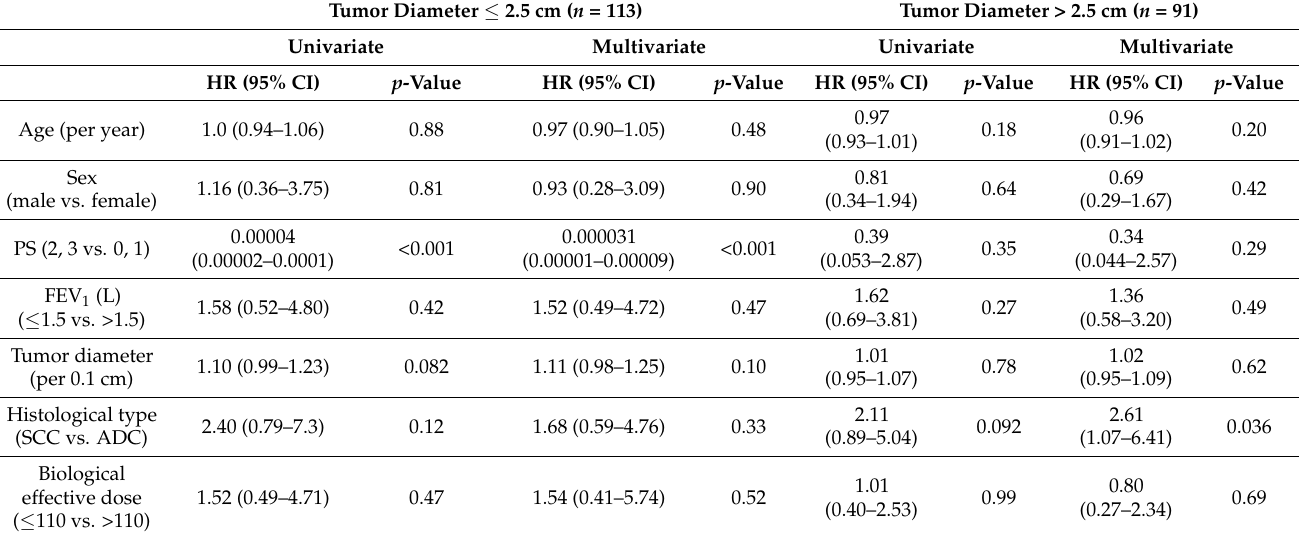
Table 4. Univariate and multivariate analyses of local recurrence in tumor diameter ≤ 2.5 cm and >2.5 cm